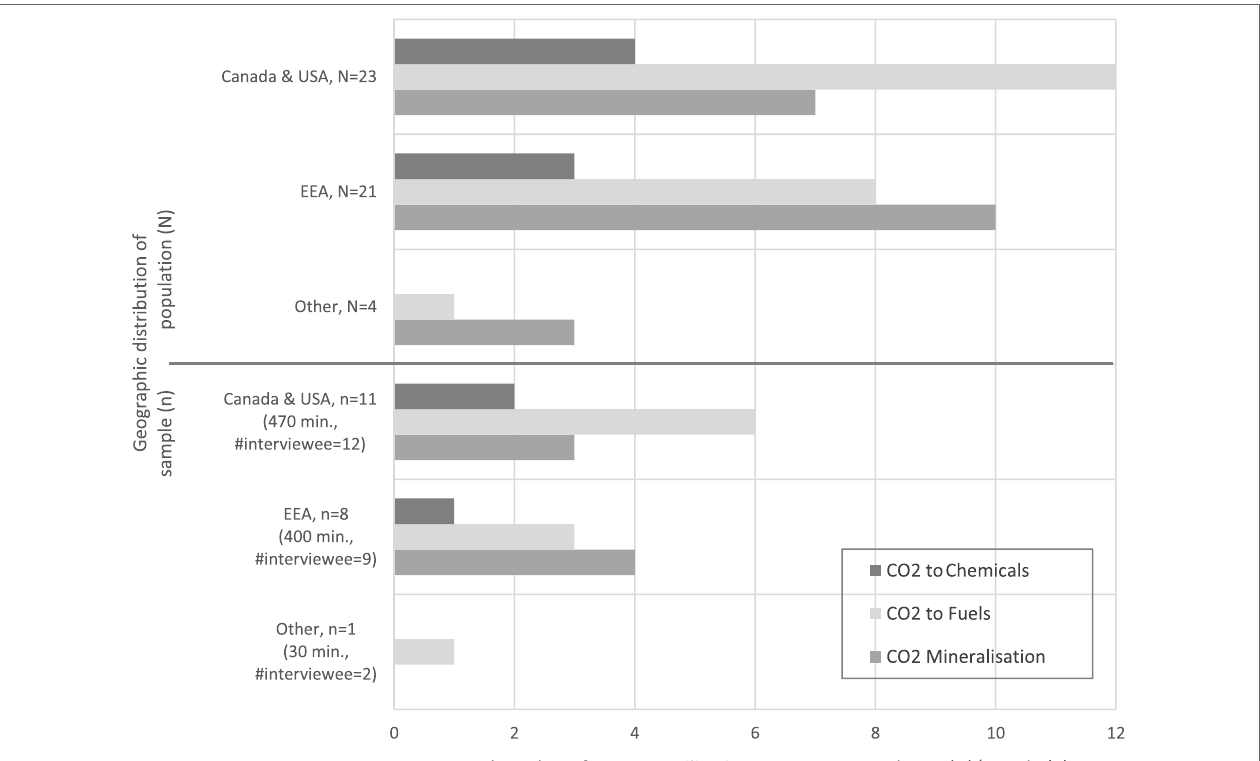
FigUre 2 | Overview of the identified population and